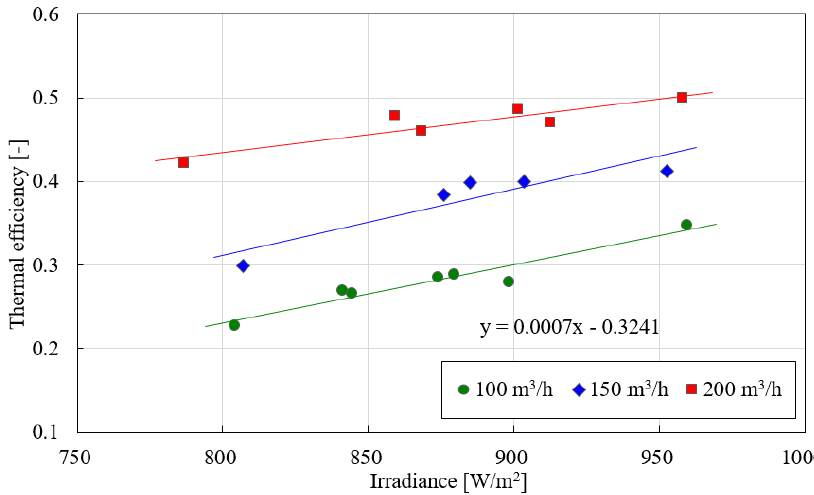
Figure 5. Effect of the irradiance on the thermal efficiency.